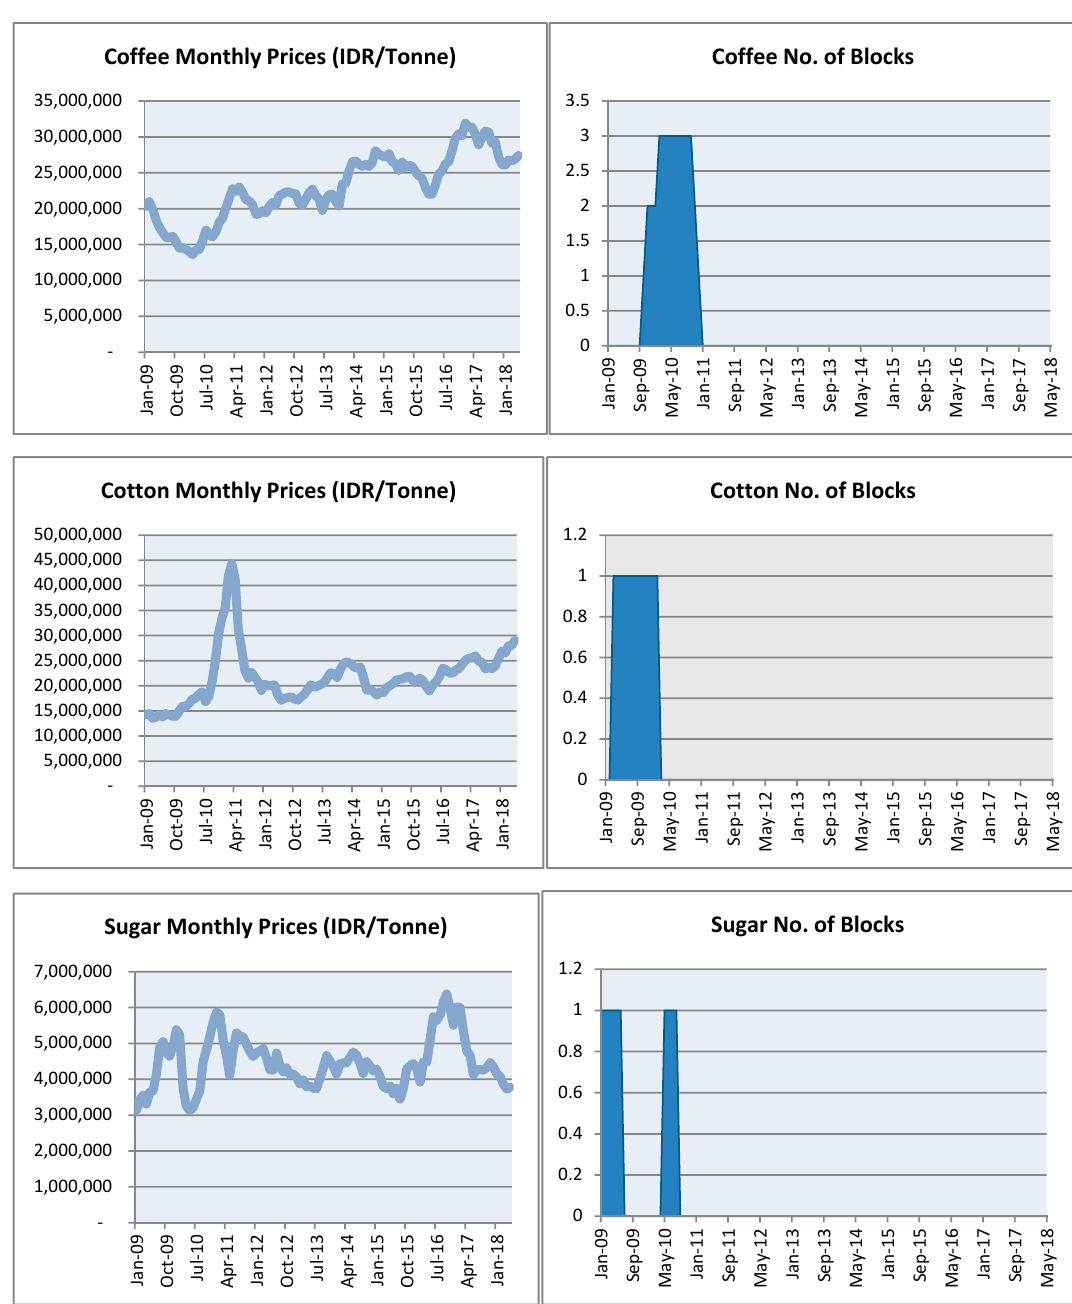
Figure 1. Changes in CRD Reserves of Various Commodities by the Indonesian CRD over the Period of 2009–2018.